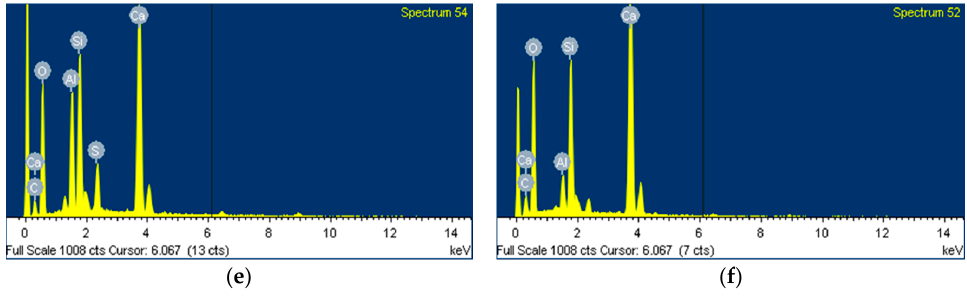
Figure 13. The microstructures of mixture B-0-N at 60 days: BSE images magnified by ( a ) ×3000; ( b ) ×1500; ( c ) ×3000 and ( d ) ×5000; EDS spectra of ( e ) point 1 in ( c ); and ( f ) point 2 in ( d ).